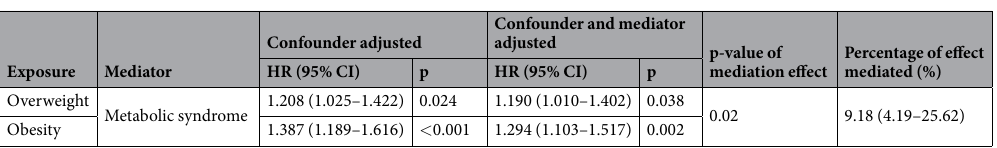
Table 3. Percentage of excess risk mediated by body mass index or the metabolic syndrome.